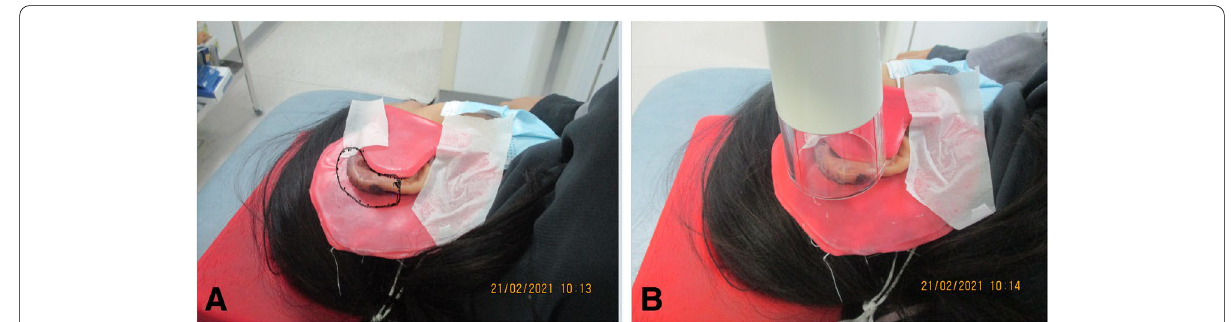
Fig. 2 Patient with Rt ear keloid treated by orthovoltage. A Showed patient with RT ear keloid with target volume determined and waxed lead shield used for normal tissue protection. B Showed the same patient with orthovoltage applicator prior to